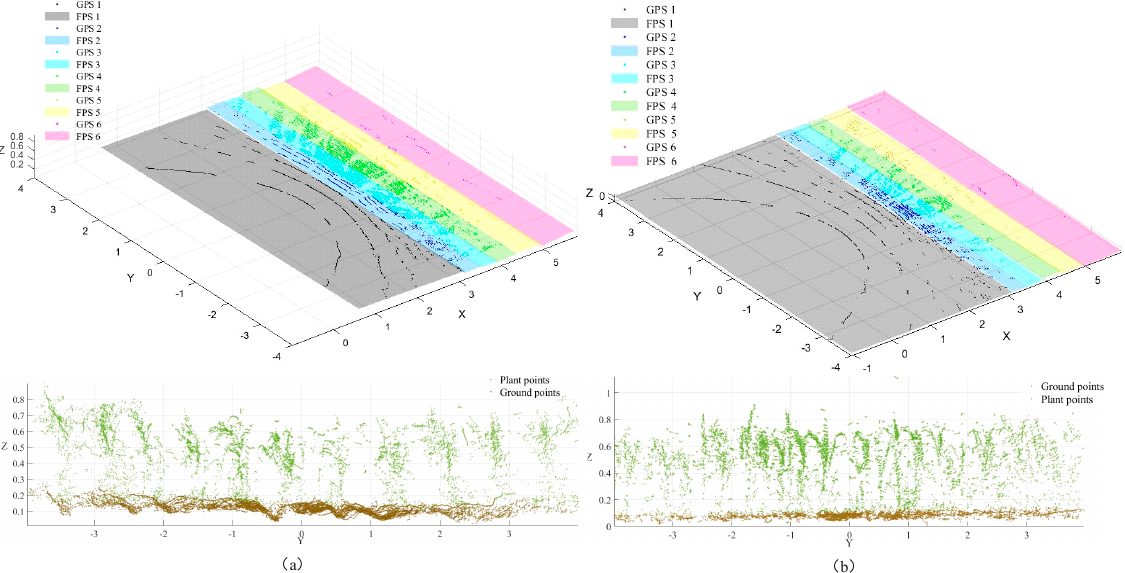
Figure 5. Effect of surface filtering. ( a ) Maize field data of 48 growth days; ( b ) maize field data of 60 growth days. In the figure, “Ground Point of Slice n” is simply represented as GPS n, “Fitting Plane of Slice n” is simply represented as FPS n.